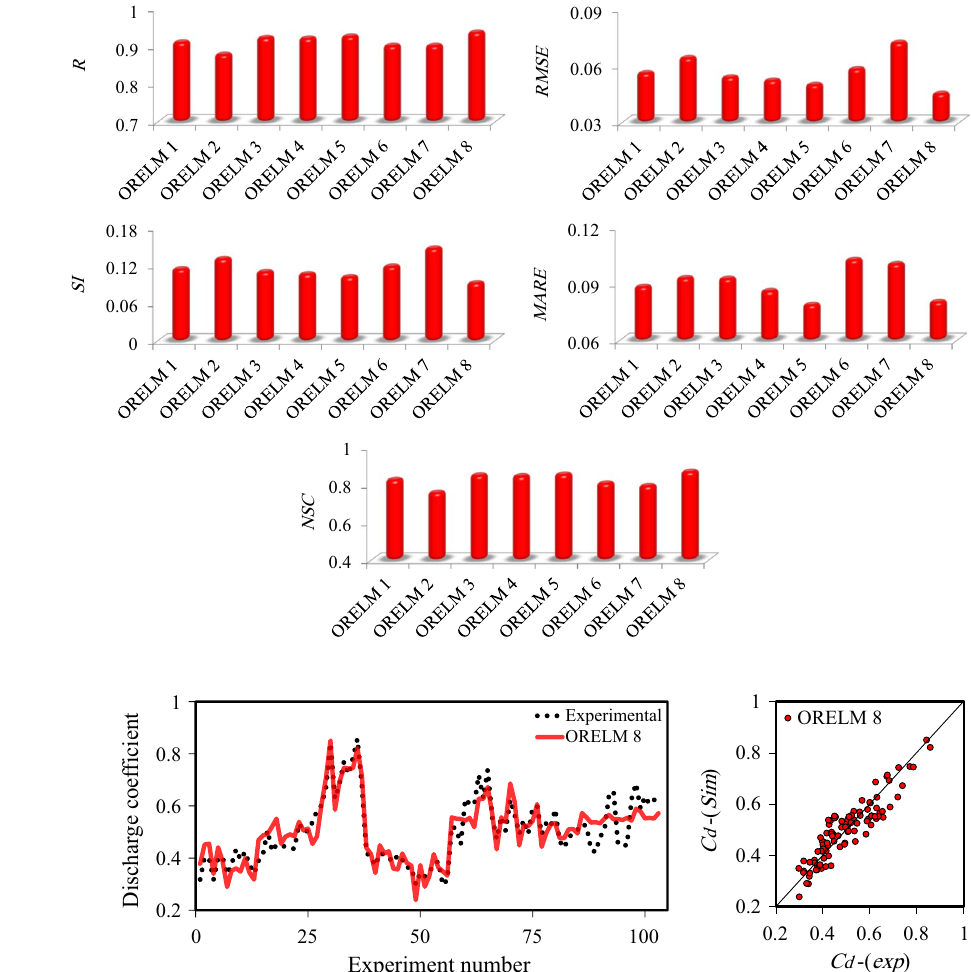
Fig. 8 Results of statistical